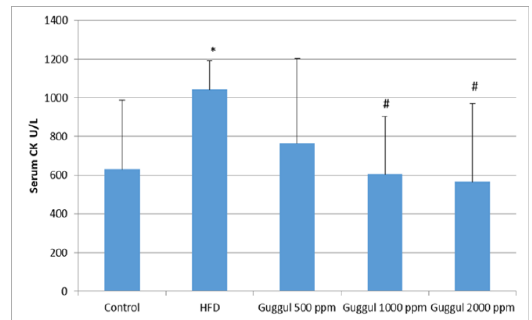
Figure (9) Effects of guggulsterone on serum CK level of mice models with high-fat diet induced NAFLD.